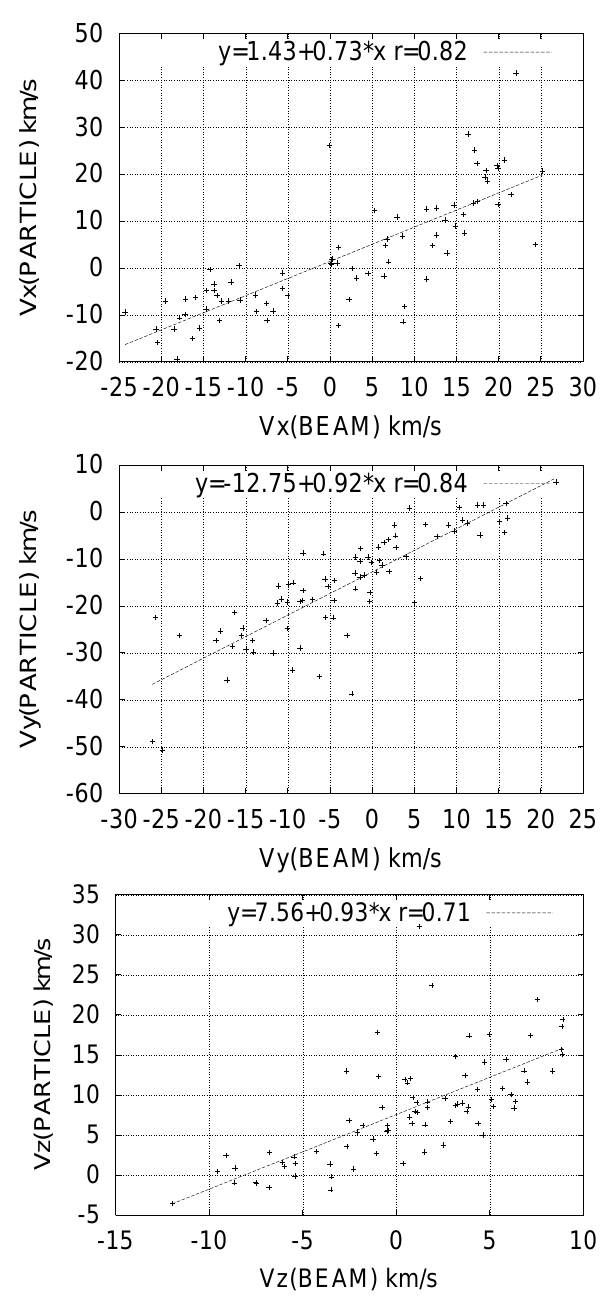
Fig. 7. Correlation between convections obtained by the beam in- strument and those by the particle instrument. The regression lines and the correlation coefficients are also shown in the